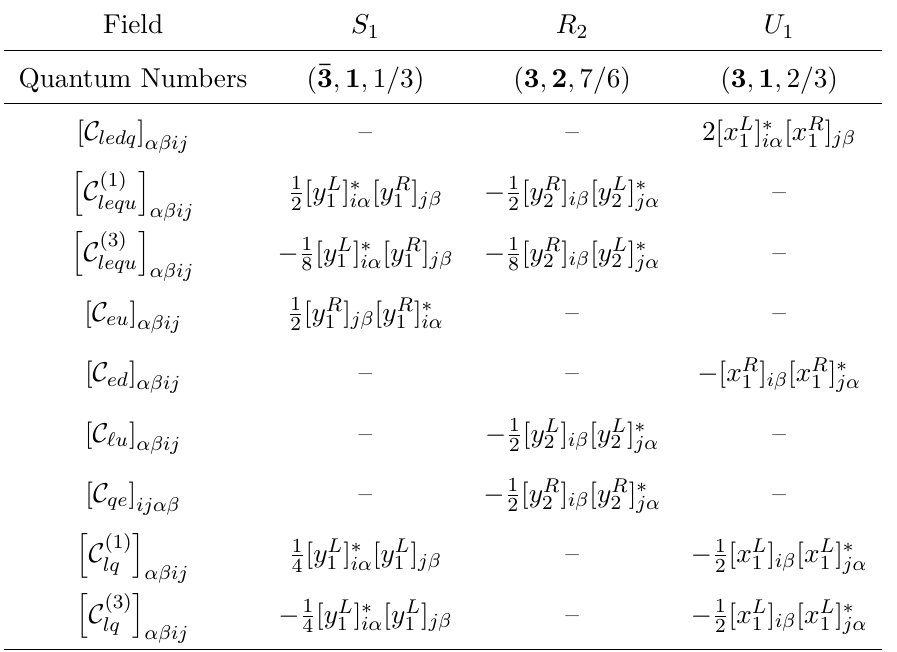
Table 4. Matching of the leptoquarks to the semileptonic operators in the Warsaw basis [43]. In the matching conditions we have set Λ = m LQ